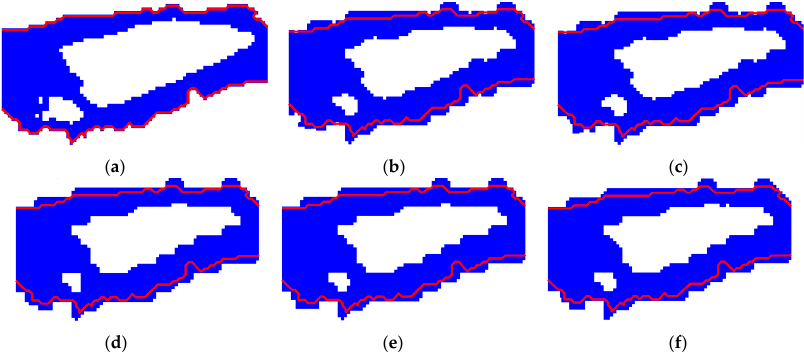
Figure 20. Sub-pixel maps obtained from real water fractions based on OBA-NDWI algorithm for Sarca River: ( a ) reference map, sub-pixel maps of ( b ) PS, ( c ) MBPS, ( d ) bilinear, ( e ) bicubic, and ( f ) lanczos3 algorithms, ZF = 5.